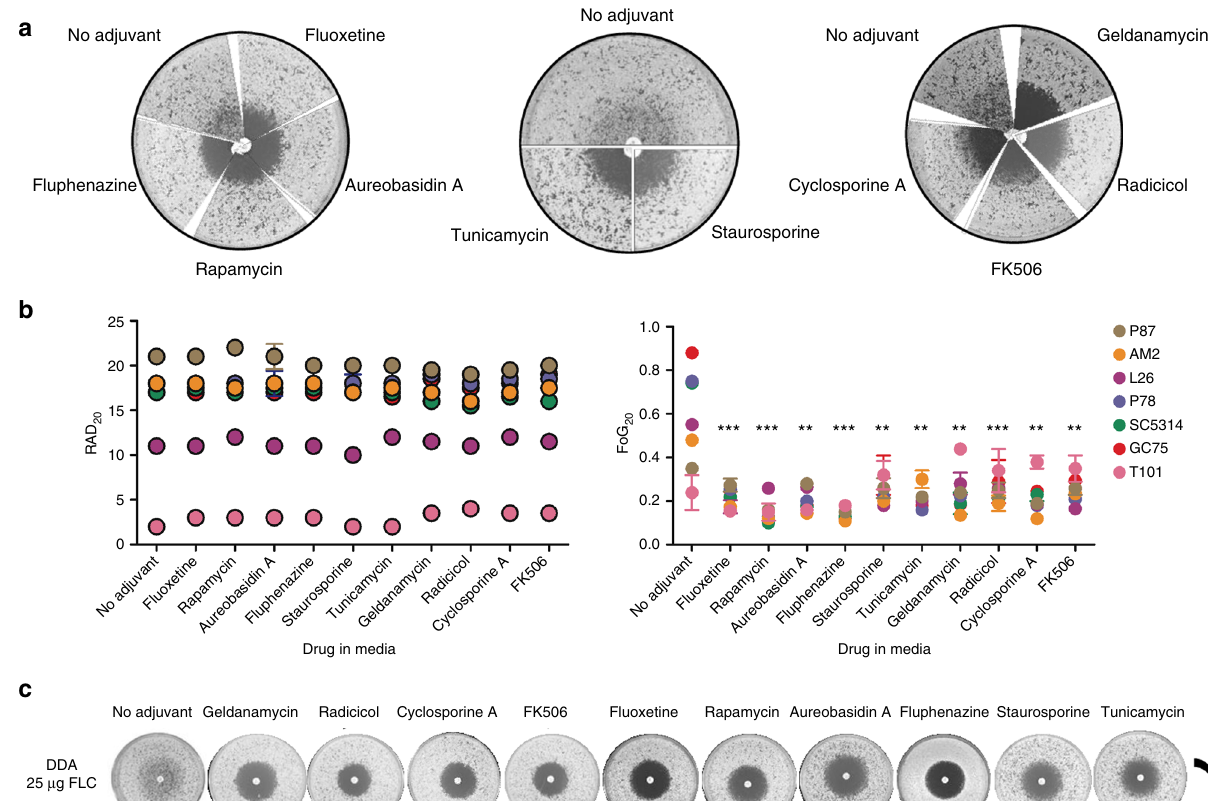
signi fi cant effect, consistent with the redundancy of ef fl ux mechanisms 55 (Fig. 4e). In addition, IRO1 (Supplementary Note 2), which is involved in iron homeostasis 26 , and VPS21 , which is involved in vacuolar traf fi cking 19 , affected FoG and not RAD. Thus, many genetic pathways affect the ability of subpopulations of cells to grow in the presence of